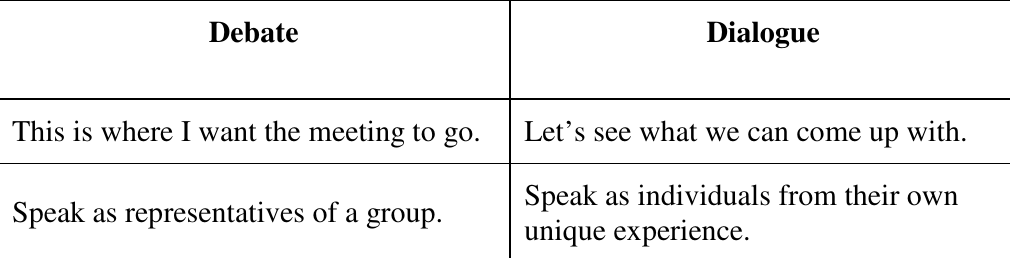
Table 1. A comparison of debate and